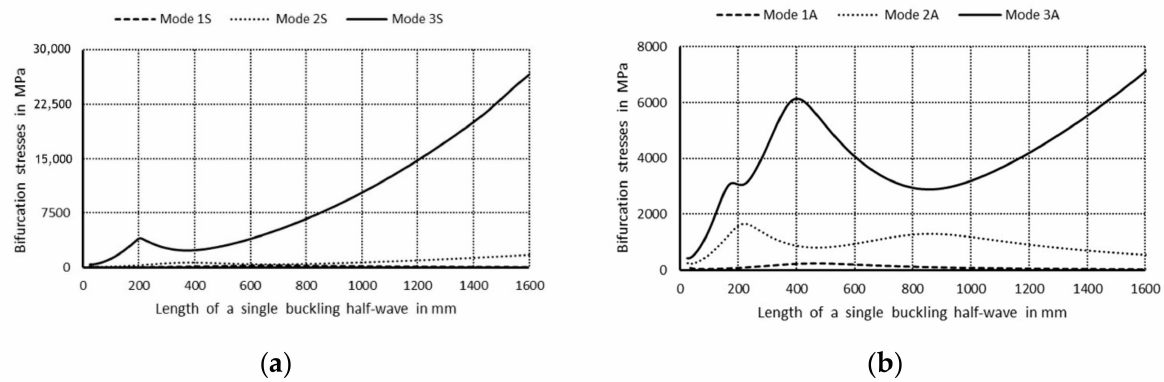
Figure 3. Values of the bifurcational stress in MPa versus the length of a single buckling half-wave in mm: ( a ) first three symmetrical buckling modes, ( b ) first three anti-symmetrical buckling